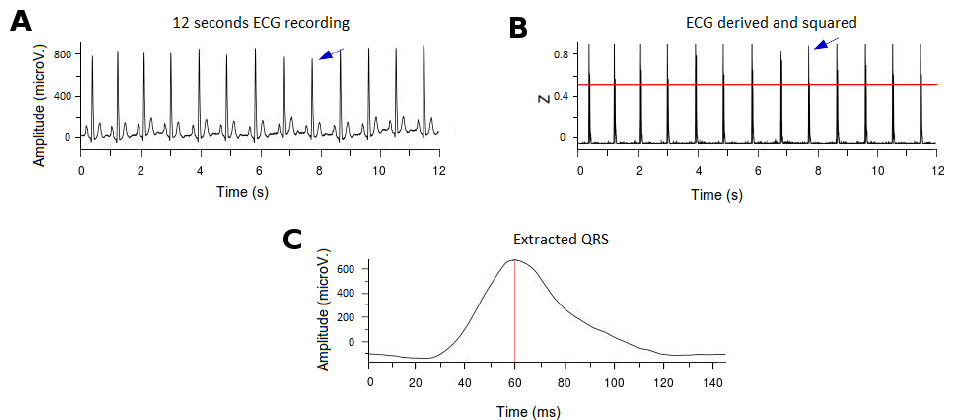
Figure 2. Example of the ECG processing and the QRS extraction. ( A ): Surface ECG (12 consecutive seconds). The blue arrow indicates a QRS complex. ( B ) Signal after derivation, square elevation and typification. The 0.6 threshold to detect the QRS complexes is denoted (red line). The blue arrow indicates a QRS complex after processing. ( C ) Example of an extracted QRS complex. The tMaxQRS is indicated by the red line. ECG: electrocardiogram.